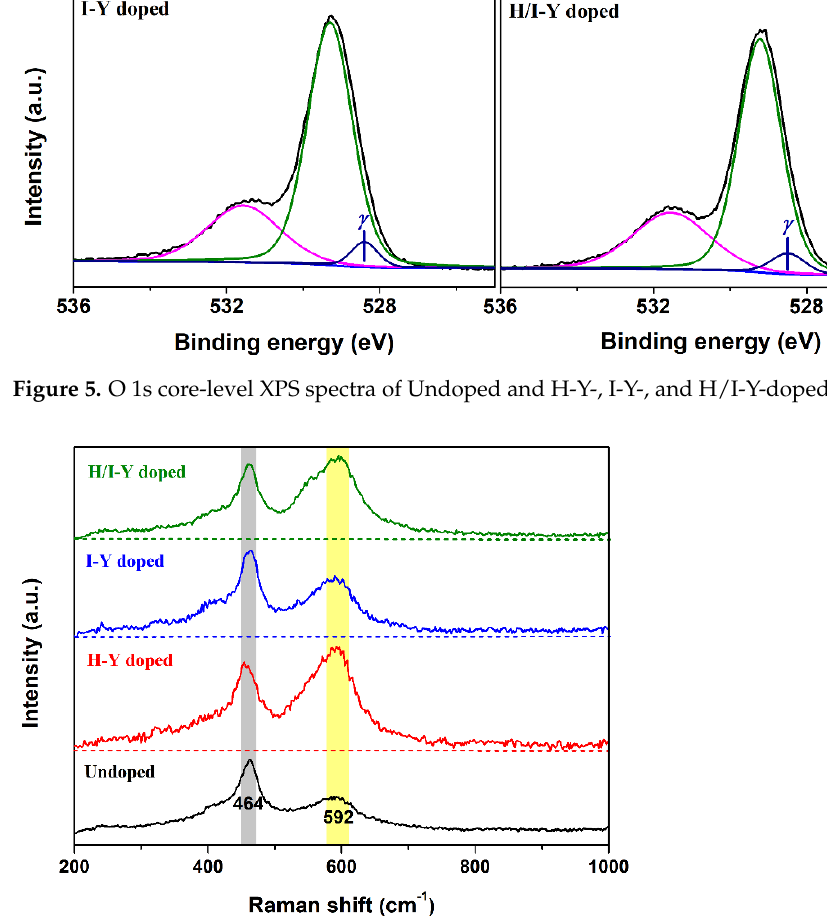
Figure 6. Raman spectra of Undoped and H-Y-, I-Y-, and H/I-Y-doped CeO 2